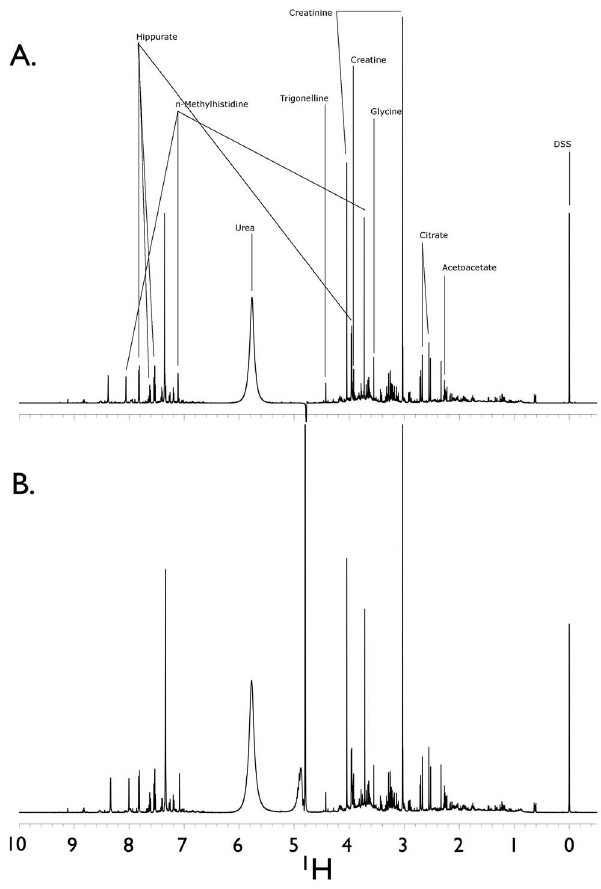
Figure 1. Hydrogen NMR spectra of two technical replicates of a single volunteer human urine sample. Data were collected on two separate NMR spectrometers. The first replicate ( A ) was run on a Varian VNMRS 600 MHz spectrometer equipped with 5 mm HX probe and a 768AS (automatic sample handling) robotic system at the University of Alberta. The second replicate ( B ) was run on a Varian VNMRS 500 MHz equipped with a 5 mm ‘‘One-probe’’ with Z-axis pulsed field gradients and an Agilent/Varian 7510-AS sample handling system at the University of Michigan’s Biochemical NMR Core Laboratory. The induced saturation power or c B 1 (and calibrated excitation pulses) for the 600 and 500 MHz spectrometer data was 80 Hz (90 u pulse) and 98 Hz (96 u pulse was the default robotic setting), respectively. A representative number of named metabolites and their assigned spectral peaks are shown as well as the internal standard, DSS. DSS=4,4-dimethyl-4-silapentane-1-sulfonic acid.